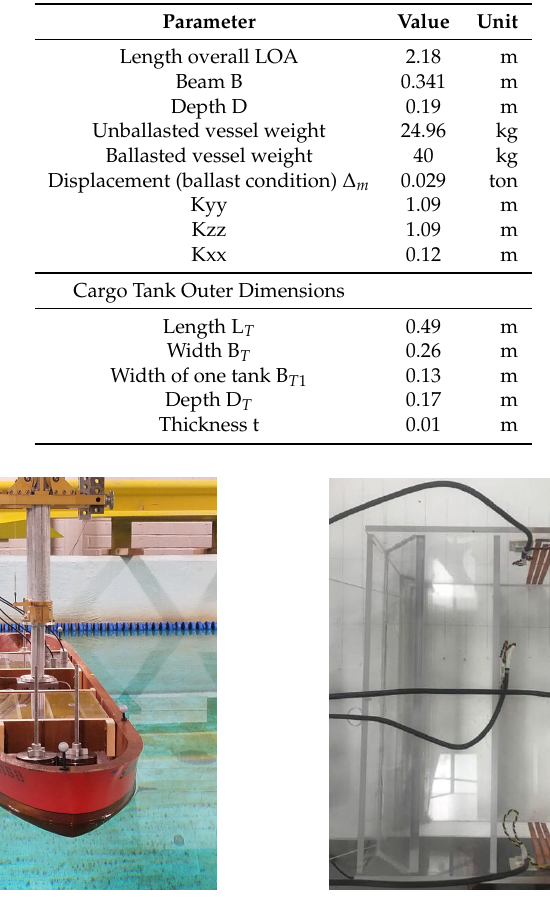
Table 1. FPSO and cargo tank characteristics.